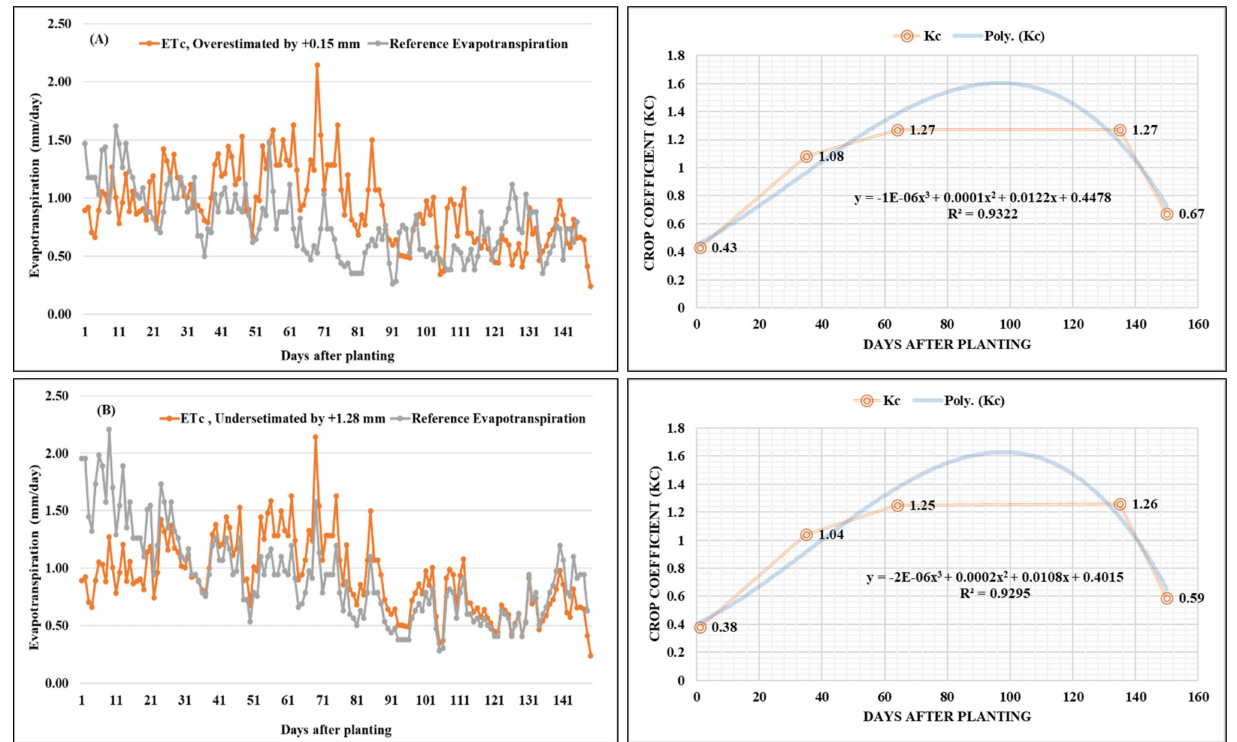
Figure 14. Crop coefficient, K c , of the chrysanthemum (variety Zembla) crop at ( A ) 2019–2020 and ( B )